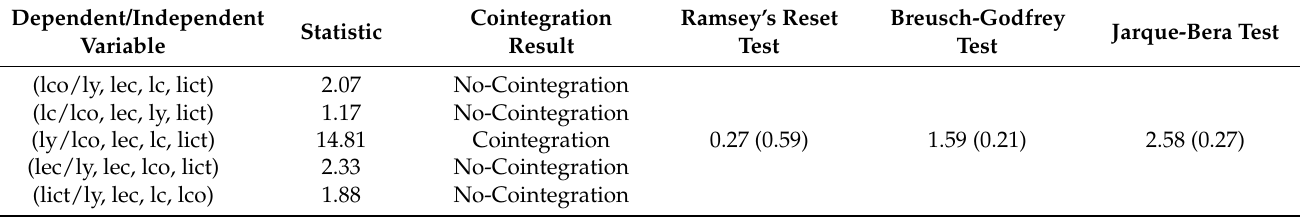
Table 6. The Results of the Panel ARDL Bounds Testing Cointegration